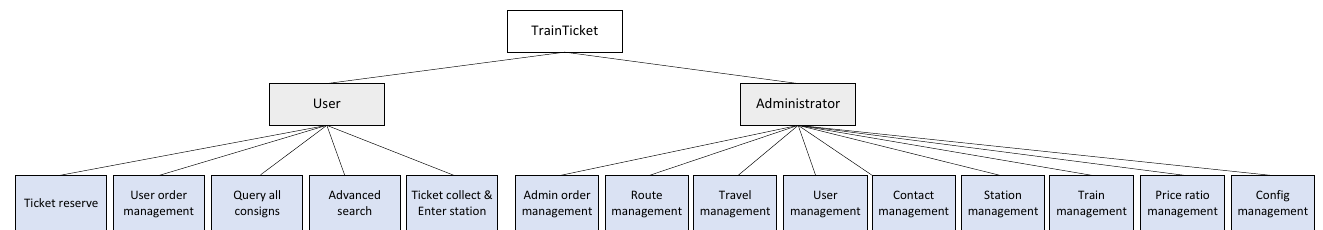
Figure 7. The business scenarios hierarchy of TrainTicket. The fourteen business scenarios are divided into two categories: user and administrator. We denote the fourteen business scenarios of Ticket reserve , User order management , . . . , and Config management as BS 1 , BS 2 , . . . , and BS 14 , respectively.